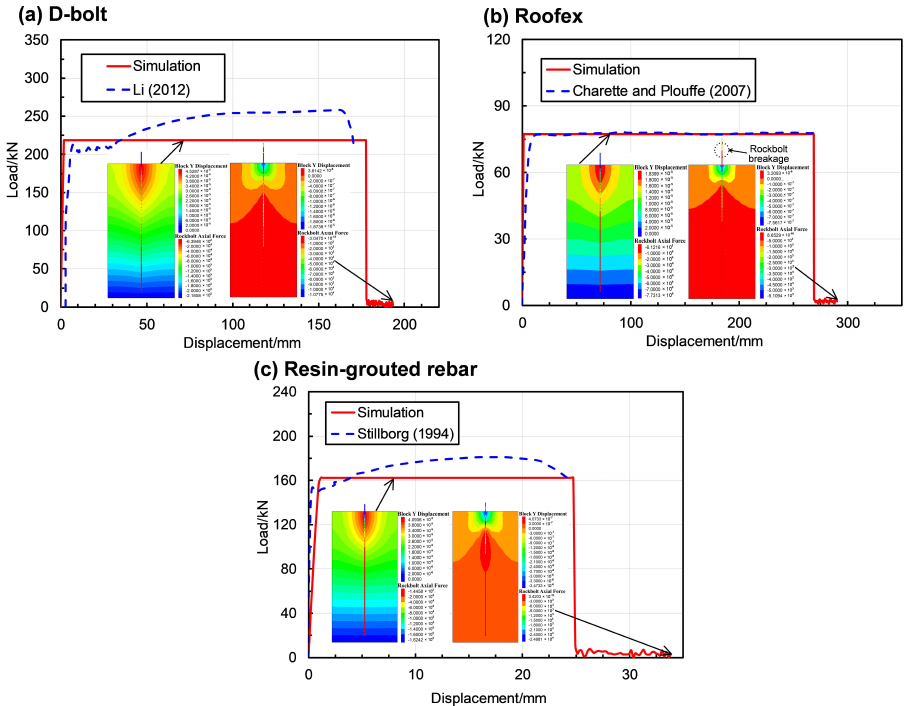
Figure 11. Simulated load-displacement curves and axial forces of rockbolts and deformation of rock Table 1. This is a table caption. Tables should be placed in the main text near to the first time they masses. (Rockbolt axial force in N and block Y displacement in are cited.